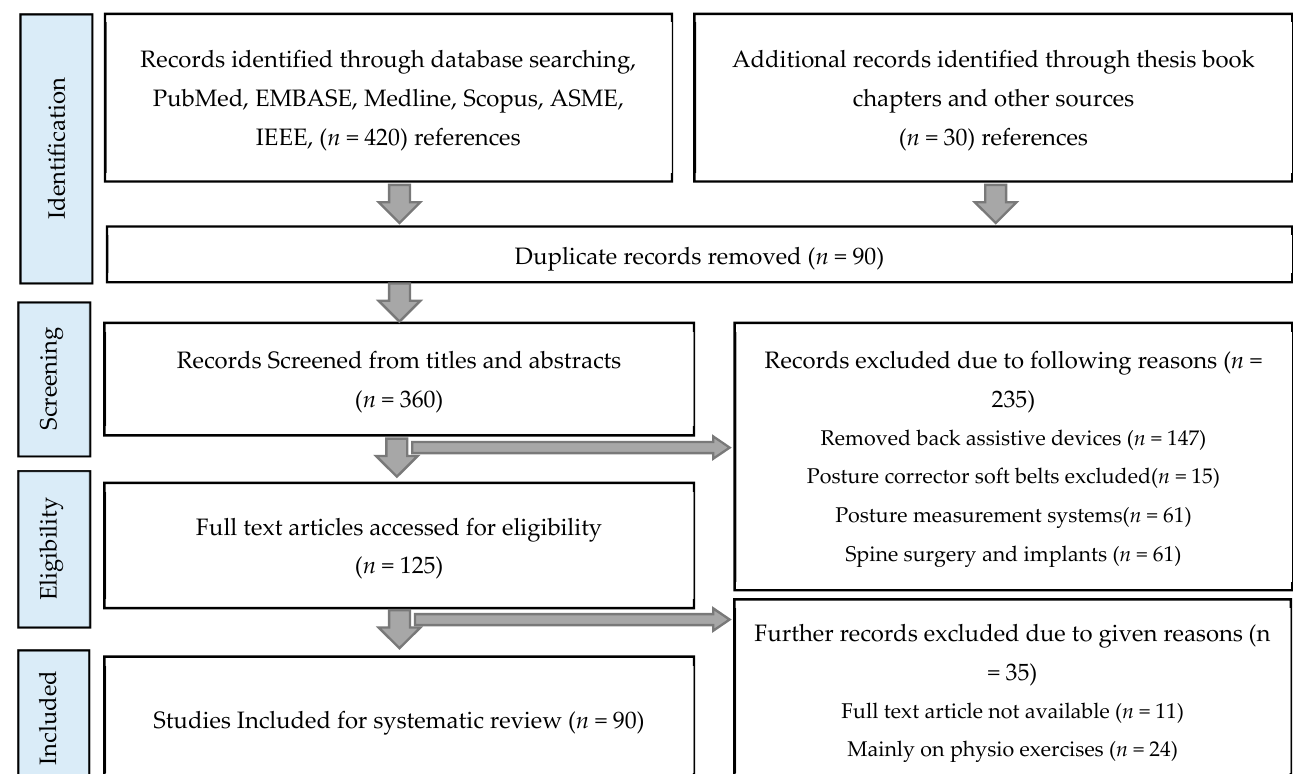
Figure 1. Systematic review article selection flowchart.